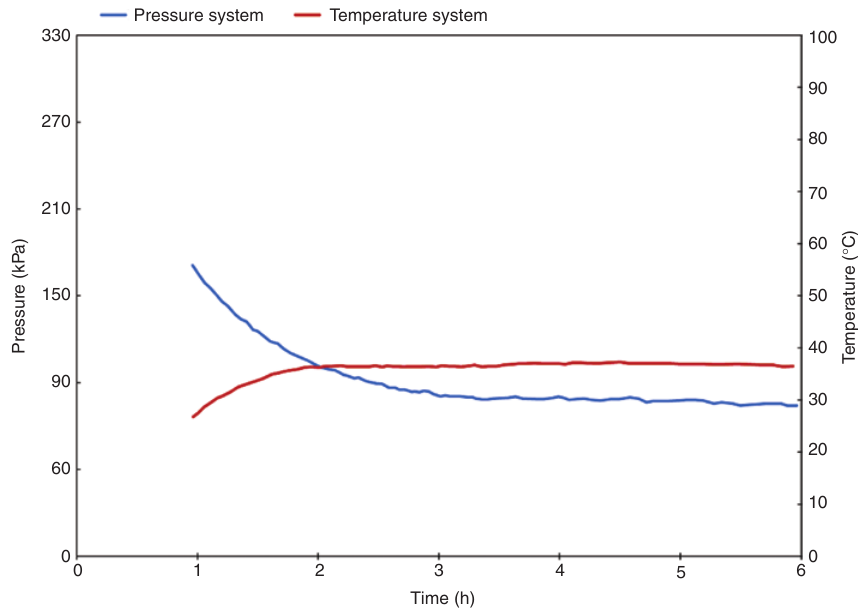
Figure 3: Dependence of the vial temperature and pressure on the ball milling